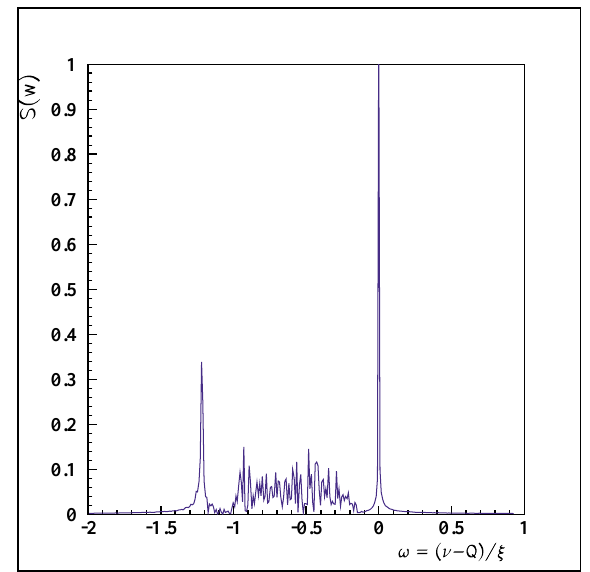
FIG. 3. (Color) Frequency spectrum of the bunch centroid mo- tion (for 2 17 turns, N (cid:1) 10 4 macroparticles) for round beams. The grid covers from 2 10 s to 10 s , the rest of the particles be- ing treated as halo particles. The horizontal axis gives the tune shift from the unperturbed tune Q in units of j , i.e., w (cid:1) n2 Q The vertical axis is the corresponding amplitude. The p and s oscillation modes are clearly